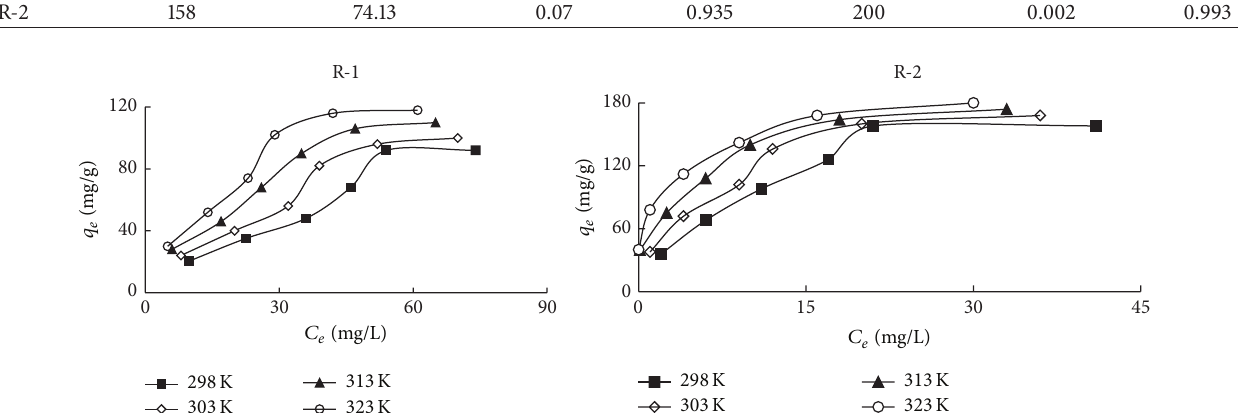
Figure 6: Effect of adsorption temperature on adsorption process.